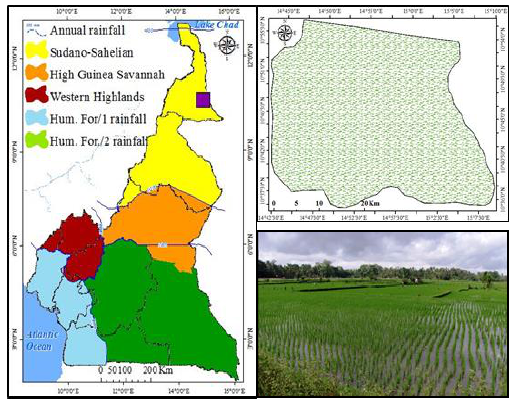
Figure 1. Maga’s Floodplain, the study